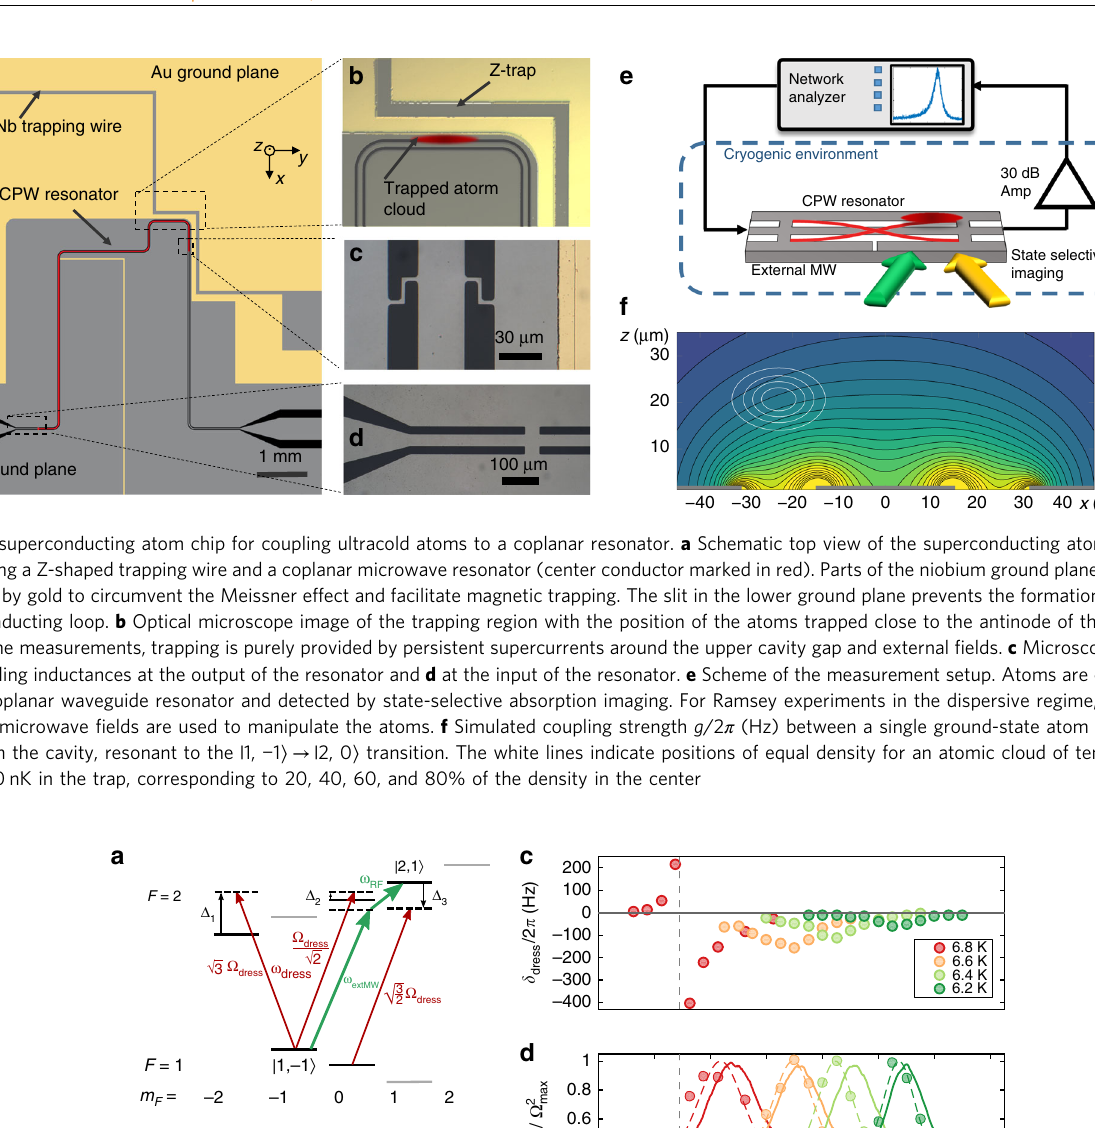
Ω 2 state | 2, 1 〉 , on the other hand, is coupled to state | 1, 0 〉 . This leads the off-resonant fi eld shifts the atomic states by δ dress ¼ ± dress Δ , to a shift in the two-photon transition frequency | 1, − 1 〉 → | 2, 1 〉 by where Ω dress denotes the Rabi frequency of the dressing fi eld and − ω fi eld and the Δ = ω dress 0 is the detuning between the dressing atomic transition frequency. The plus (minus) sign is valid for the ¼ (cid:2) Ω 2 (cid:3) δ ground (excited) state. The level scheme of the atoms involving all dress dress relevant fi elds is depicted in Fig. 2a. For a MW fi eld which is linearly polarized perpendicular to the quantization axis, as it is in − and σ + -transitions with our case, the cavity fi eld induces σ which is measured in our experiment (Supplementary Note 5 for equal fi eld strength, as depicted by the red arrows. This fi eld details). Here, Δ i , i ∈ {1, 2, 3} denotes the detuning to the relevant atomic hyper fi ne transition. The numerical factors in the hence couples the state | 1, − 1 〉 to the states | 2, − 2 〉 and | 2, 0 〉 . The